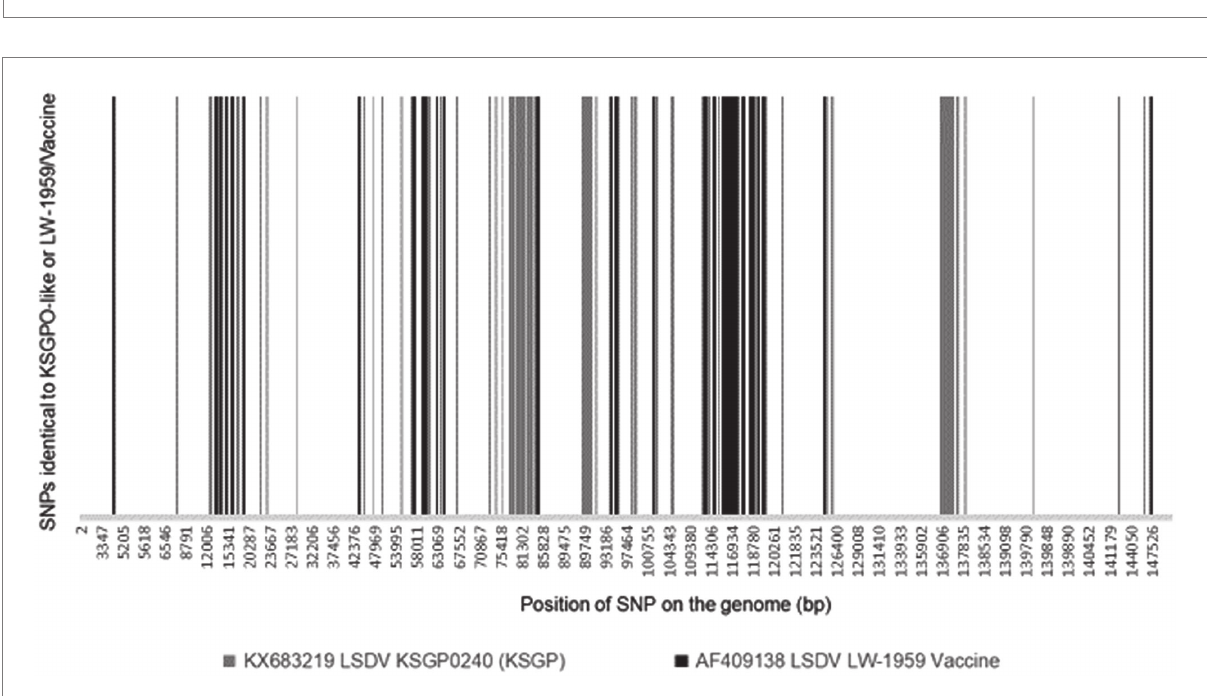
FIGURE 7 Graphical representation of the genomic positions under selection for either KSGPO-240 (gray) or LW-1959 (black) polymorphisms (Picture from Krotova et al.,